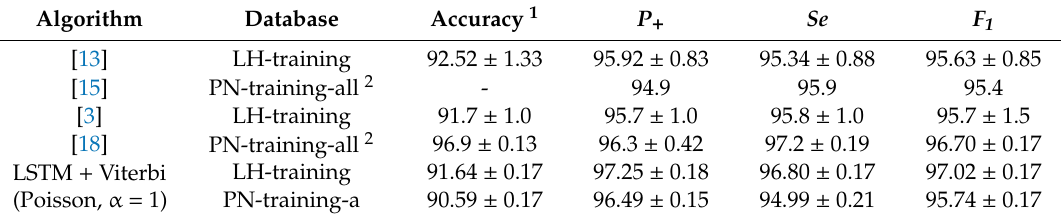
Table 4. Comparison of the results of recent several algorithms and TCN + Viterbi (Poisson, α = 1) (%).